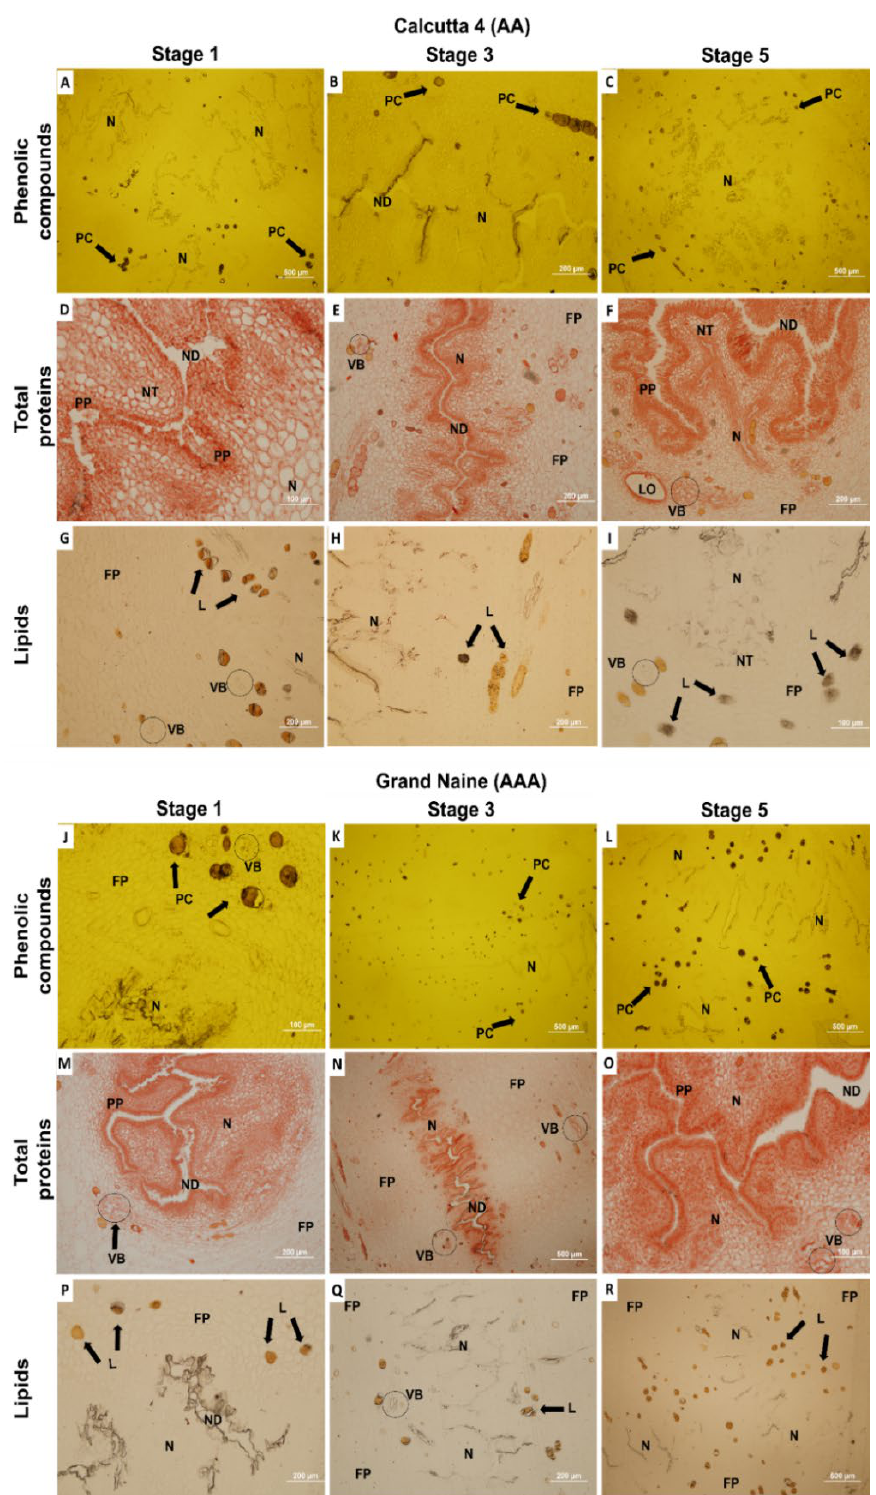
Figure 4. Sections representing the developmental stages of septal nectaries of Calcutta 4 and Grand Naine subjected to different histochemical tests. Longitudinal sections: ( A , C , D , F , G , I , J , L , M , O , P , R ). Cross-sectional sections: ( B , E , H , K , N , Q ). PC, phenolic compounds; ND, nectariferous duct; VB, vascular bundle; L, lipids; LO, loculus; N, nectary; FP, fundamental parenchyma; PP, pluristratified papillae. The white bars represent 100 µm ( D , I , J , O ), 200 µm ( B , E , F , G , H , M , P , Q ), and 500 µm ( A , C , K , L , N , R ).